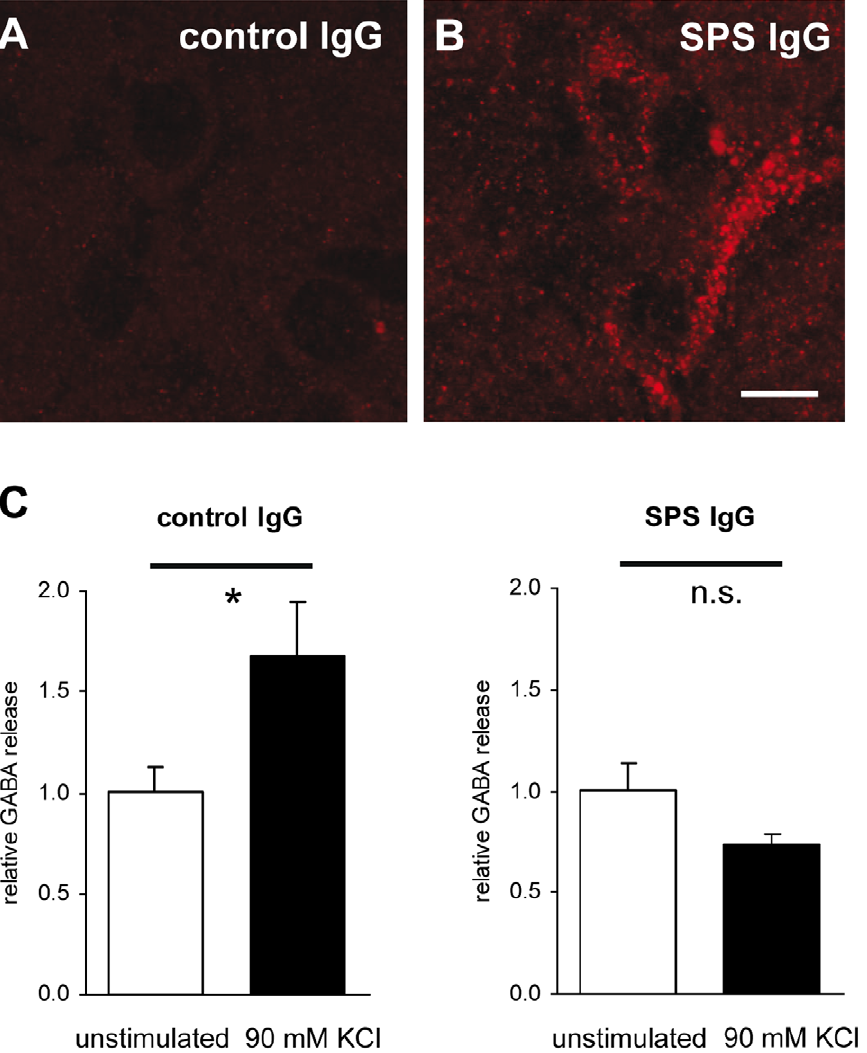
Figure 5. SPS IgG accumulates in interneurons of rat amygdala complex and reduces GABA release from hippocampal neurons. In rats treated intrathecally with SPS IgG (A) but not in those treated with control IgG (B), immunoreaction against human IgG showed positive staining of neurons in the amygdala complex (scale bar: 10 m m). (C) Dissociated hippocampal neurons from E18 mouse embryos were incubated with SPS or control IgG. The increase of GABA release into the supernatants induced by stimulation with 90 mmol KCl was absent in SPS IgG treated neuronal cell cultures as demonstrated by HPLC analysis (* p , 0.05, Student’s t-test).